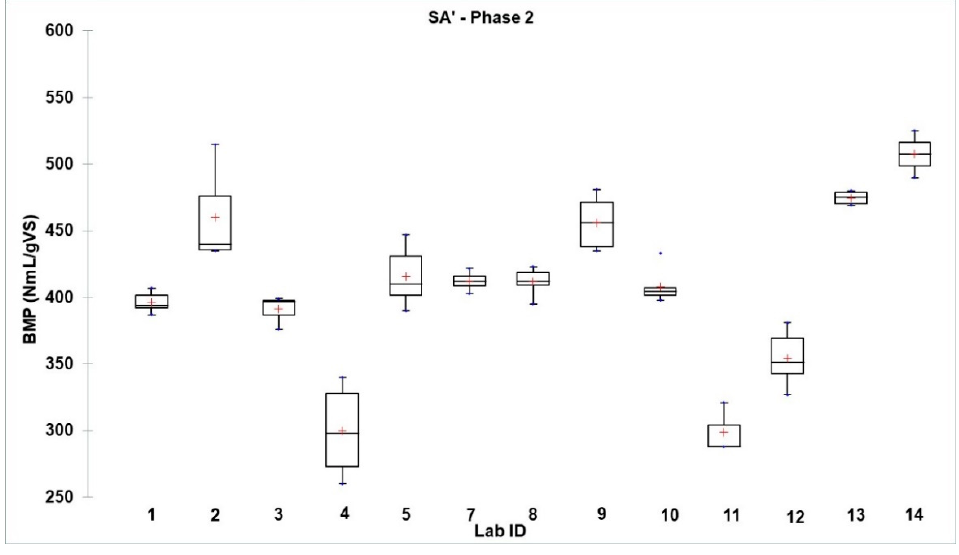
Figure 7. Summary of BMP values measured for the results of the second phase—harmonized protocol showing intra-laboratory repeatability and intra-laboratory reproducibility: ( a ) SA’; ( b ) SB; ( c ) SC.